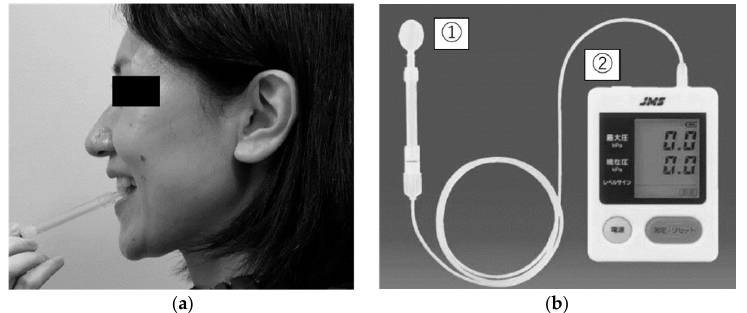
Figure 1. Tongue pressure measurement (Tongue pressure device; JMS Co., Ltd., Hiroshima, Japan). ( a ) Balloon probe; ( b ) Tongue pressure device.